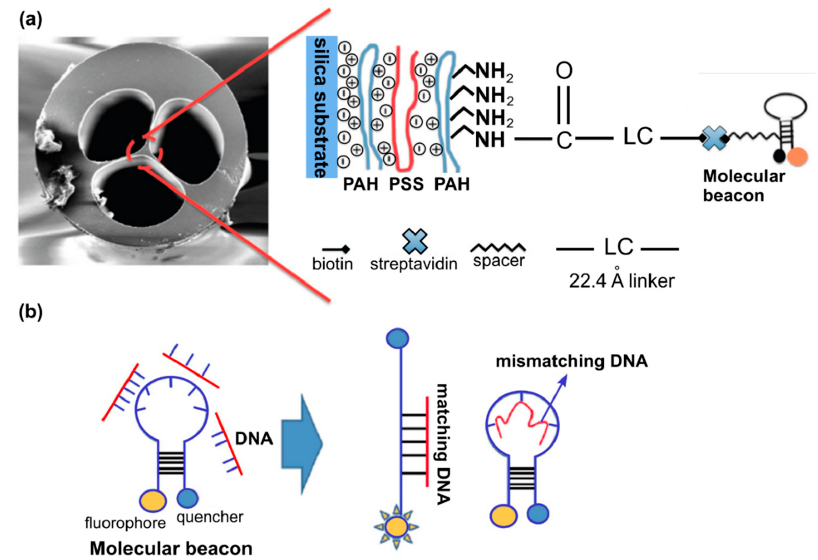
Figure 9. ( a ) SEM image of MOF end face and schematic representation of the modification process of the MOF surface. ( b ) Molecular beacons conformational change upon hybridizing with cDNA